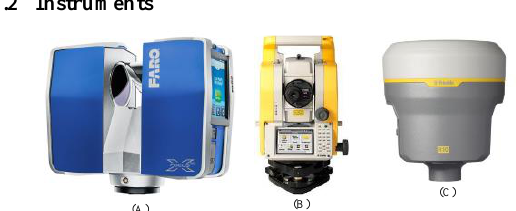
Figure 2 . Instruments used for the experiment (A) TLS, (B) Total station (TS), (C) GNSS